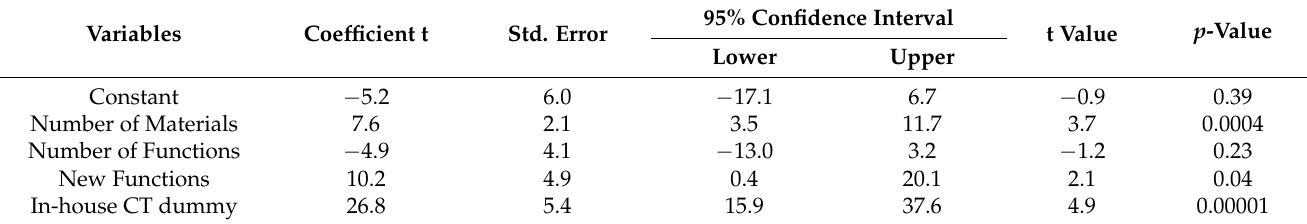
Table 8. Multiple regression analysis of product